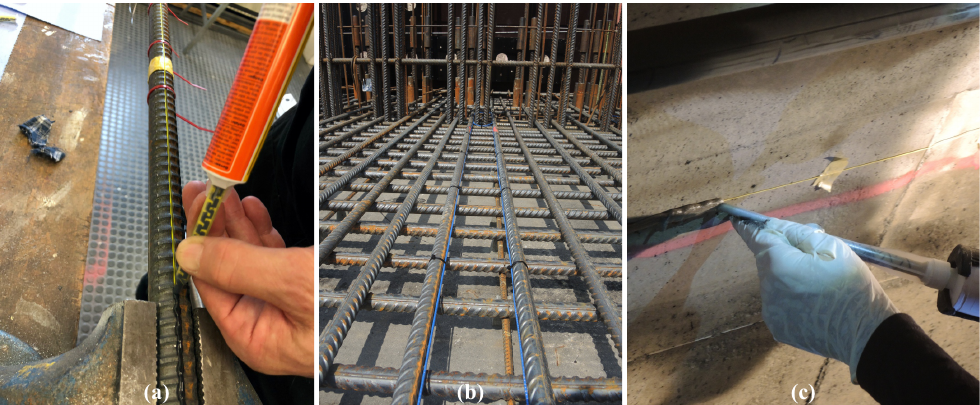
Figure 3. Sensor installation techniques: ( a ) Application along reinforcement. ( b ) Installation inside concrete. ( c ) Application along